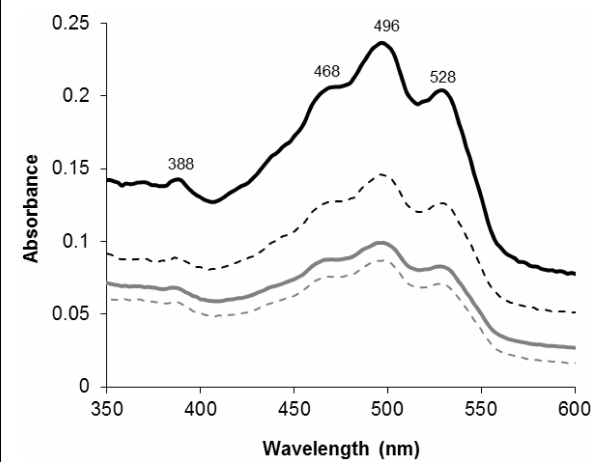
FIGURE 1 | UV-visible spectra of acetone extracted red pigments of cell pellets harvested at 86 h (solid lines) and 96 h (dashed lines) of growth from parental (gray lines) and CYP174A1 -deletion (black lines) strains of Halobacterium salinarum R1. Wavelengths of absorption maxima are indicated on the top